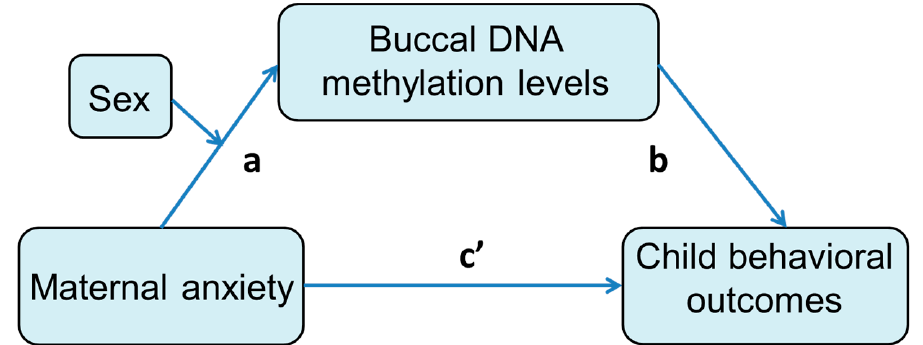
Figure 2. Theoretical model of the mediation analysis. Path a is the effect of the predictor variable on the DNA methylation (mediator), path b is the effect of the DNA methylation on the outcome variable controlling for the predictor variable, path c’ is the direct effect of the predictor variable on the outcome variable controlling for DNA methylation (mediator). The coefficient a × b represents the mediating effect of the predictor variable on the outcome variable through DNA methylation (mediator). For the moderated mediations, the index of the moderated mediation effect was (Maternal anxiety × Sex on Methylation) × (Methylation on outcomes) which tests whether the mediation is significantly moderated. All statistical analyses were performed using IBM (https://www.ibm.com) SPSS ver- sion 22.0 for Windows using α = 0.05.